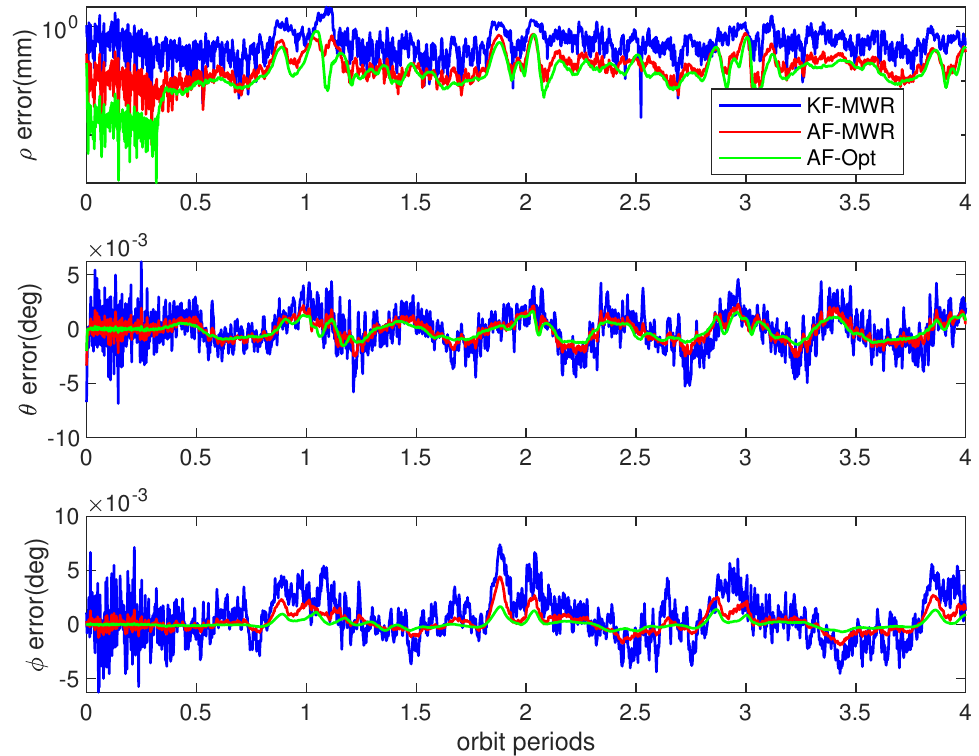
Figure 14. Relative range estimation errors from different payloads and filter algorithms. The blue lines show the relative range and azimuth/elevation estimation errors of MWR payload using the traditional Kalman filter algorithm (KF-MWR); the red lines represent the estimation errors of the MWR payload using the adaptive filter (AF-MWR); and the green lines show the estimation errors of the precise optical payload using the adaptive filter